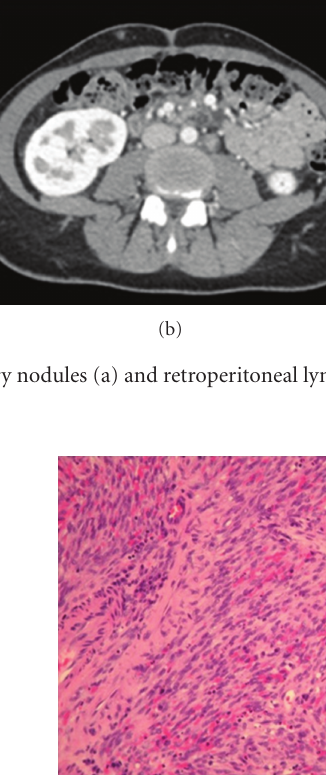
Figure 2: Microscopic findings of small bowel specimen showing atypical spindle cells with extravasated erythrocytes and capillaries (HES ×